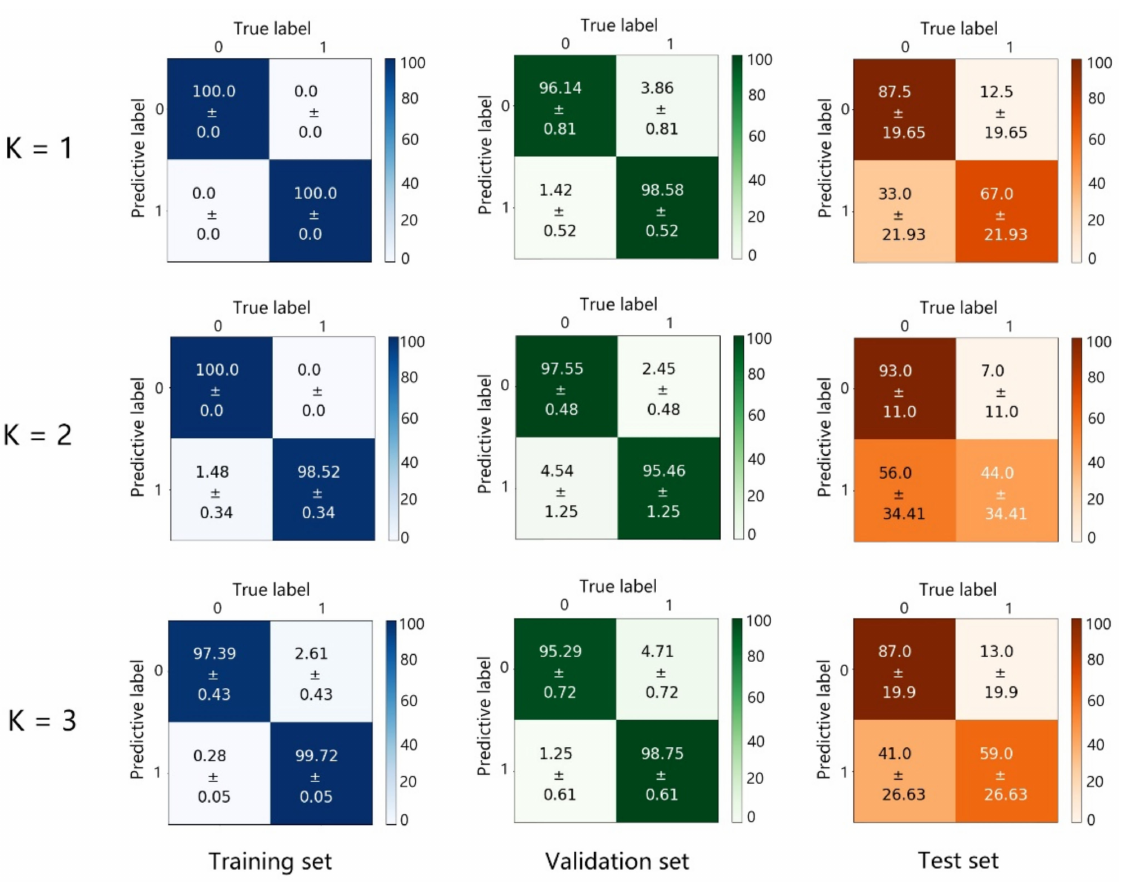
Figure 5. Confusion matrices of the training set, validation set, and test set predicted by the KNN classifier under different K values. 0: cancerous, 1: normal; unit: % in horizontal and vertical axes.